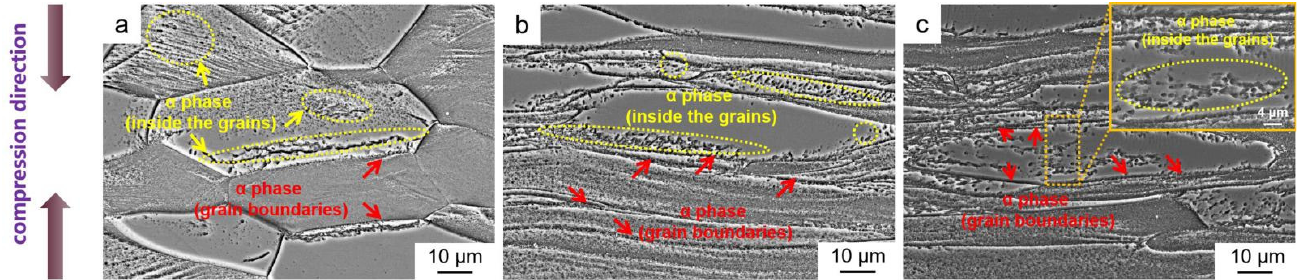
Figure 4. The hot-compressed microstructure of Ti-B12 alloy at different true strains: ( a ) 0.6, ( b ) 0.8 and ( c ) 1.2.